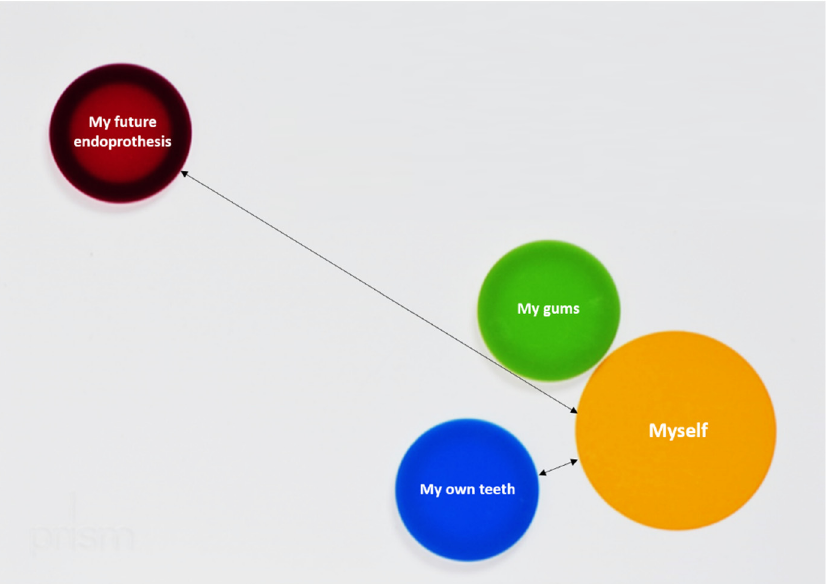
Figure 2. This figure shows the placement of different objects by a patient. The distance between the different objects and the subject was measured in millimeter. When own teeth were placed closer than the EP, like in this case, the respective cluster was rated.